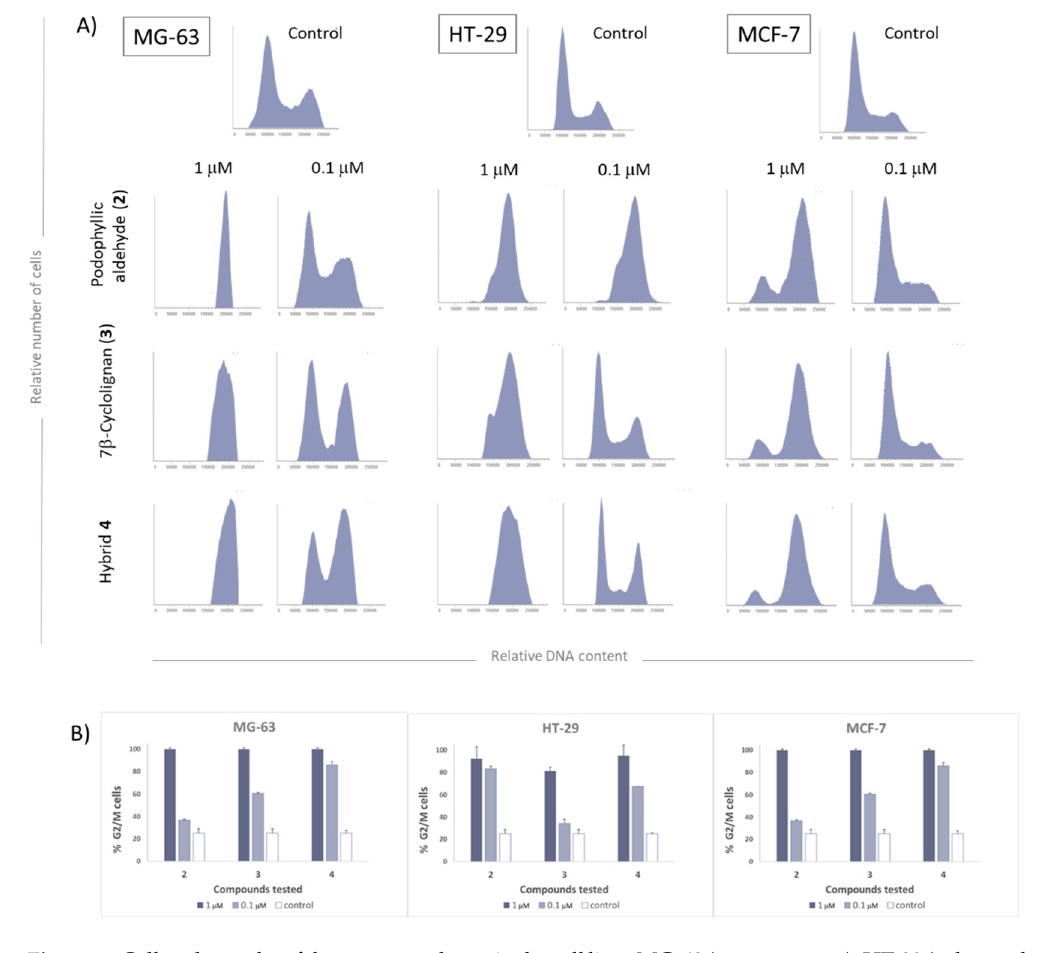
Figure 5. Cell cycle results of the compounds 2 – 4 in the cell lines MG-63 (osteosarcoma), HT-29 Figure5. Cellcycleresultsofthecompounds 2 – 4 inthecelllinesMG-63(osteosarcoma), HT-29(colorectal (colorectal cancer) and MCF-7 (breast cancer) at 24 h of incubation at 10 μ M. ( A ) Flow cytometry cancer) and MCF-7 (breast cancer) at 24 h of incubation at 10 µ M. ( A ) Flow cytometry diagrams ( B ) Cells diagrams ( B ) Cells (%) in G2/M phase dose depending. (%) in G2 / M phase dose